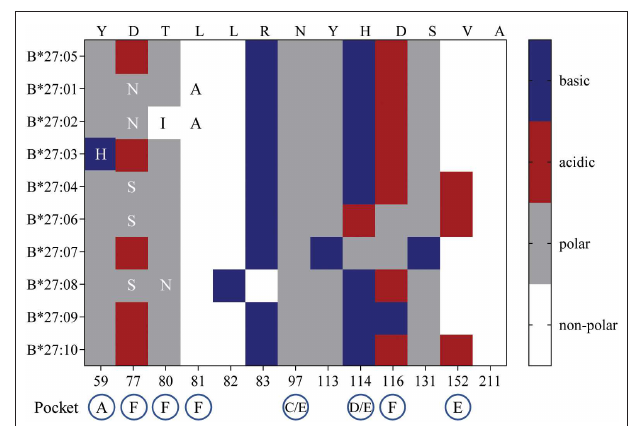
FIGURE 7 | HLA-B27 polymorphisms and amino acid chemical properties. B27:01-B*27:04, B*27:06-B*27:10 amino acid polymorphisms were compared to the consensus sequence for B*27:05. The chemical properties of substituted residues and their influence on HLA-I peptide-binding pockets are